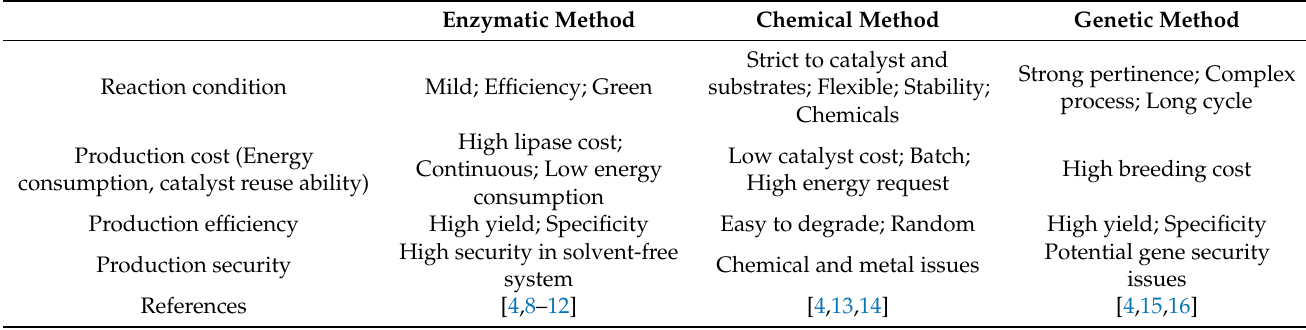
Table 1. The advantages and disadvantages of the use of different methods in SLs production. Enzymatic Method Chemical